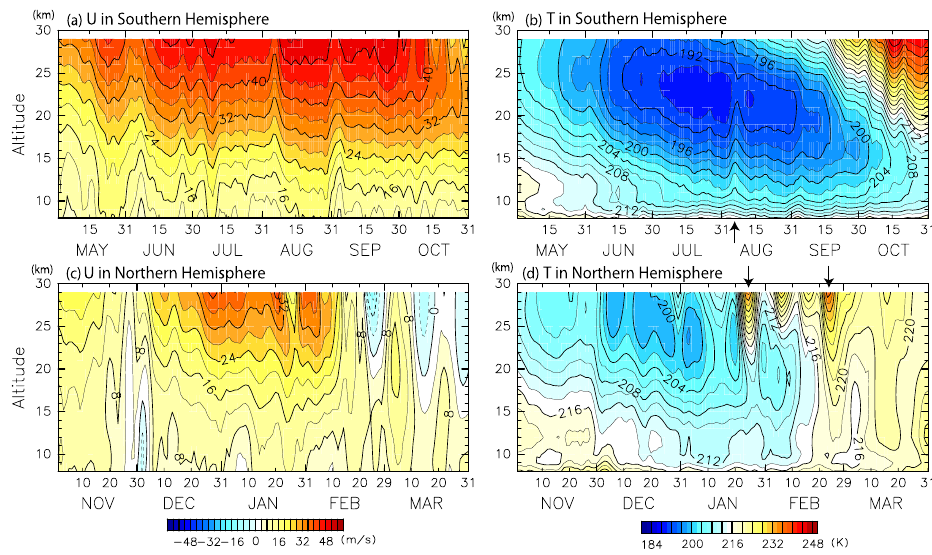
Fig. 1. Time-altitude sections of (a) U and (b) T averaged within the latitude range of 55 ◦ S–85 ◦ S in May through October 2008 and (c) U and (d) T within the latitude range of 55 ◦ N–85 ◦ N in November 2007 through March 2008. Arrows on the bottom of (b) and on the top of (d) show timings when warmings